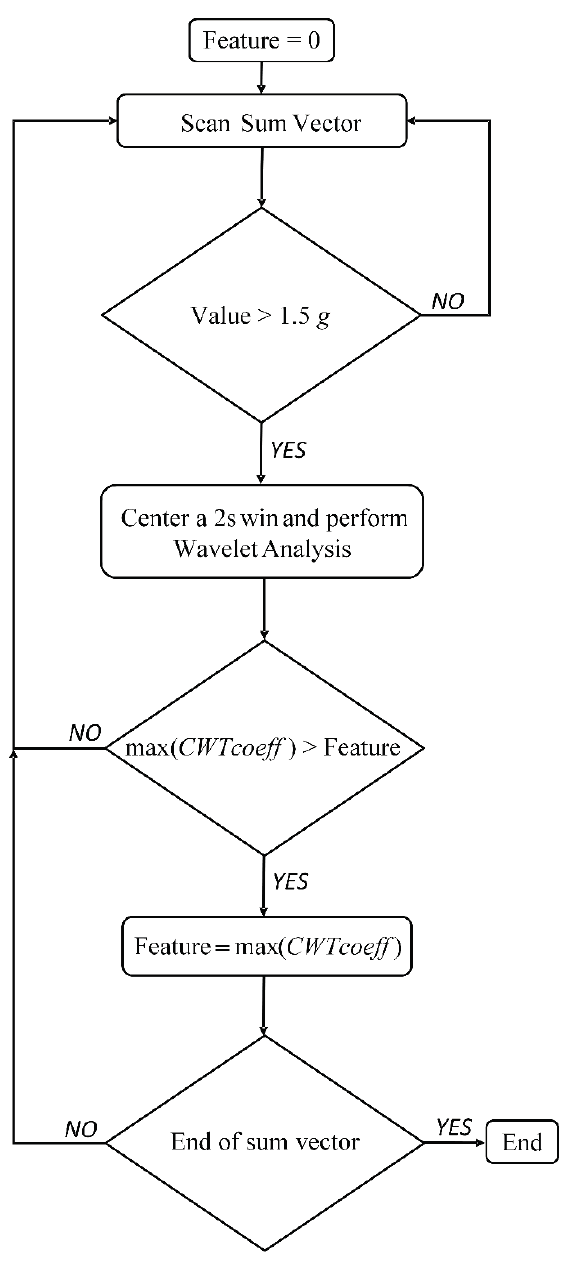
Figure 2. Workflow of the procedure that is used to compute the wavelet-based